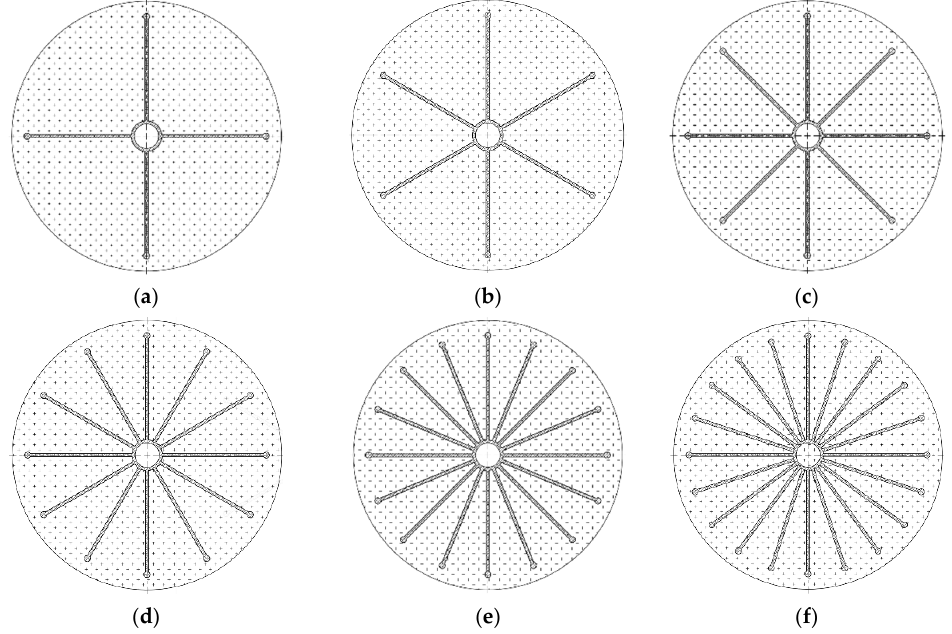
Figure 3. Cross-sections of the tubes ( t = 2.5 mm, R = 100 mm) with: ( a ) 4 fins; ( b ) 6 fins; ( c ) 8 fins; ( d ) 12 fins; ( e ) 16 fins; ( f ) 20 fins entirely covered by frost.